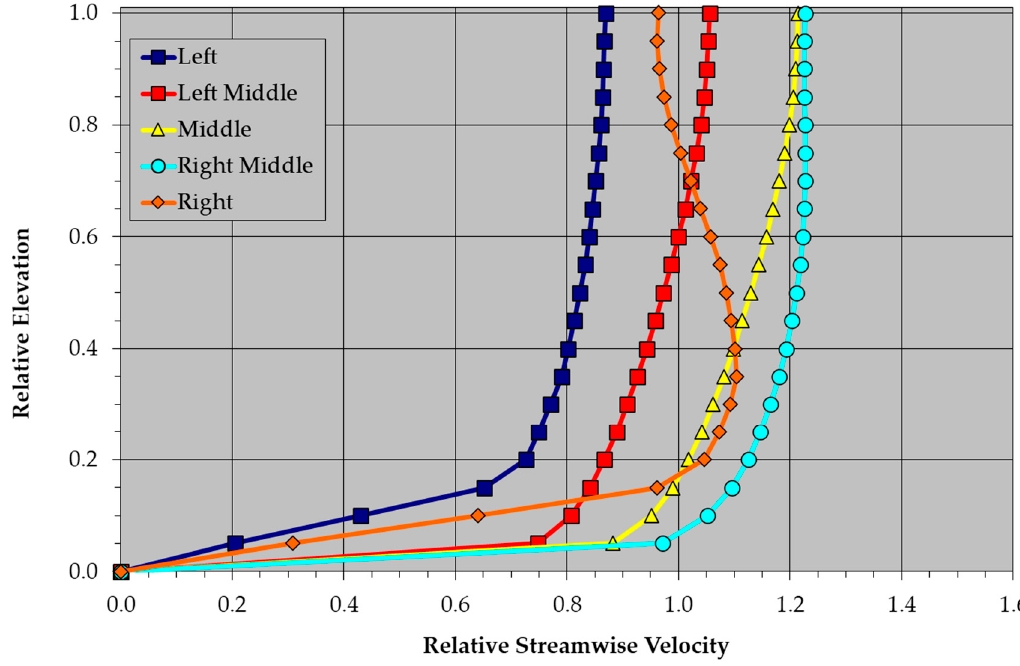
Figure 38. Vertical streamwise velocity profiles at Cross-section 702 (3rd meander bend) for Simulation Set 5 with a sinuosity of 2.75.